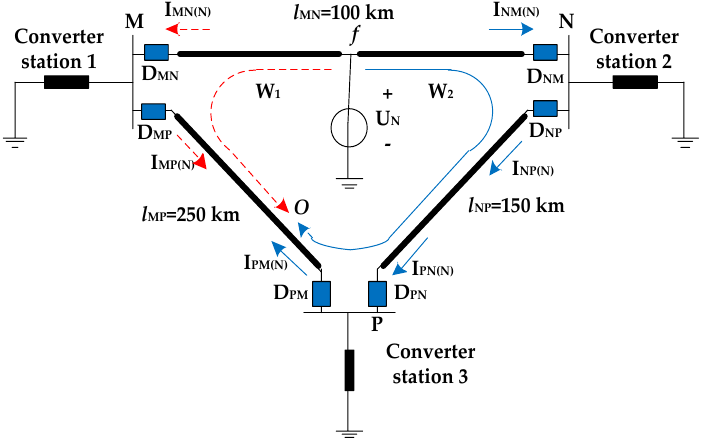
Figure 4. Fault superimposed circuit for the three-terminal MMC-based high voltage direct current (HVDC) grid.